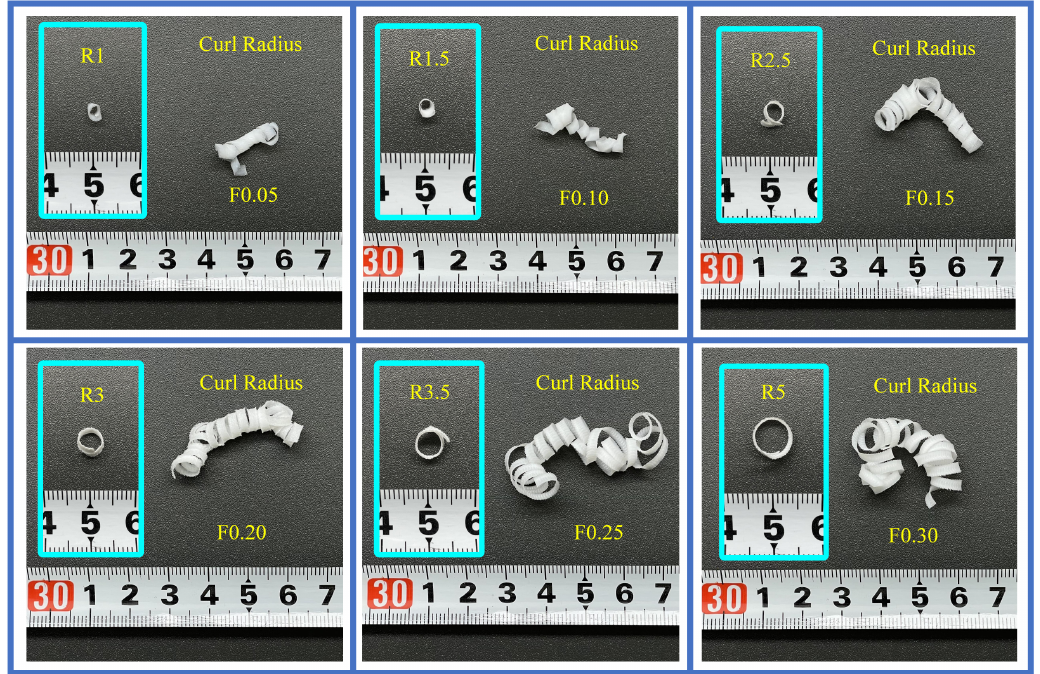
Figure 8. Surface waviness of groove surface in different